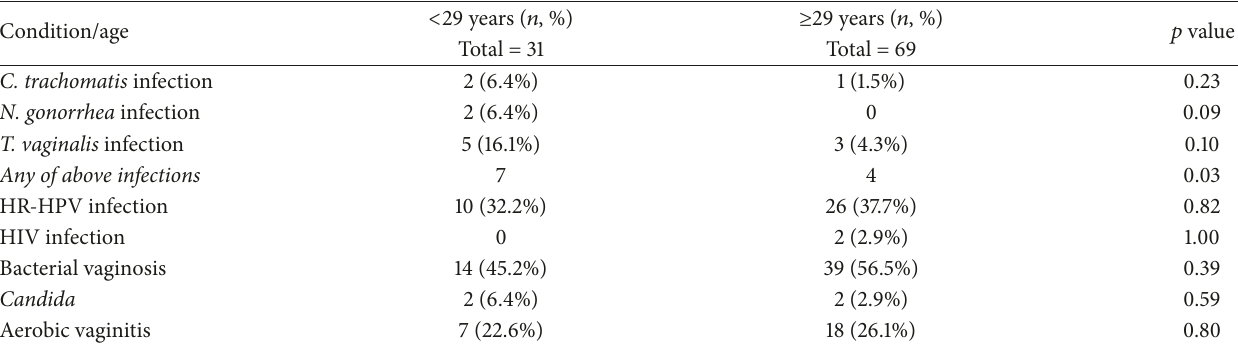
Table 2: STIs and microbiome changes in population in 100 unselected women of Pr´ıncipe Island. For BV, Candida and AV data were only present for 97